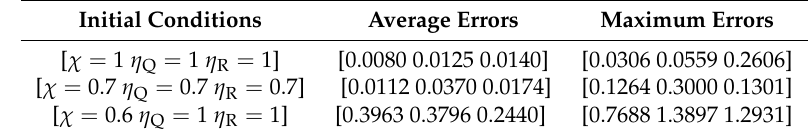
Table 1. The errors of the state estimation for the fresh cell with various initial conditions.